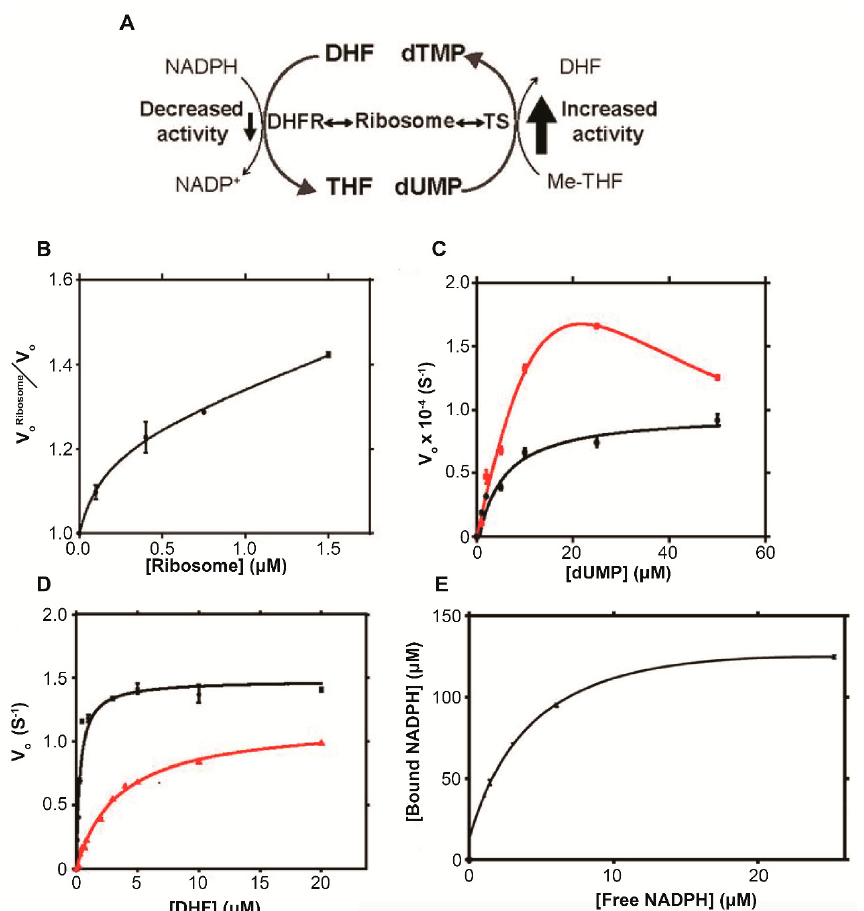
Figure 10. Ribosomes modulate TS and DHFR enzymatic activities. ( A ) Function linkage between TS and DHFR in the thymidylate synthetic pathway ( B ) Increase in TS activity with increasing ribosome concentration. ( C ) Kinetic activity profile for TS without (black) and with (red) 0.5 µM ribosome. ( D ) Kinetic activity profile for DHFR without (black) and with (red) 0.5 µM ribosome. ( E ) NADPH binding to ribosomes. The concentration of ribosomes was 1 µM. Figure is adapted from DeMott et al . (2017) [26].